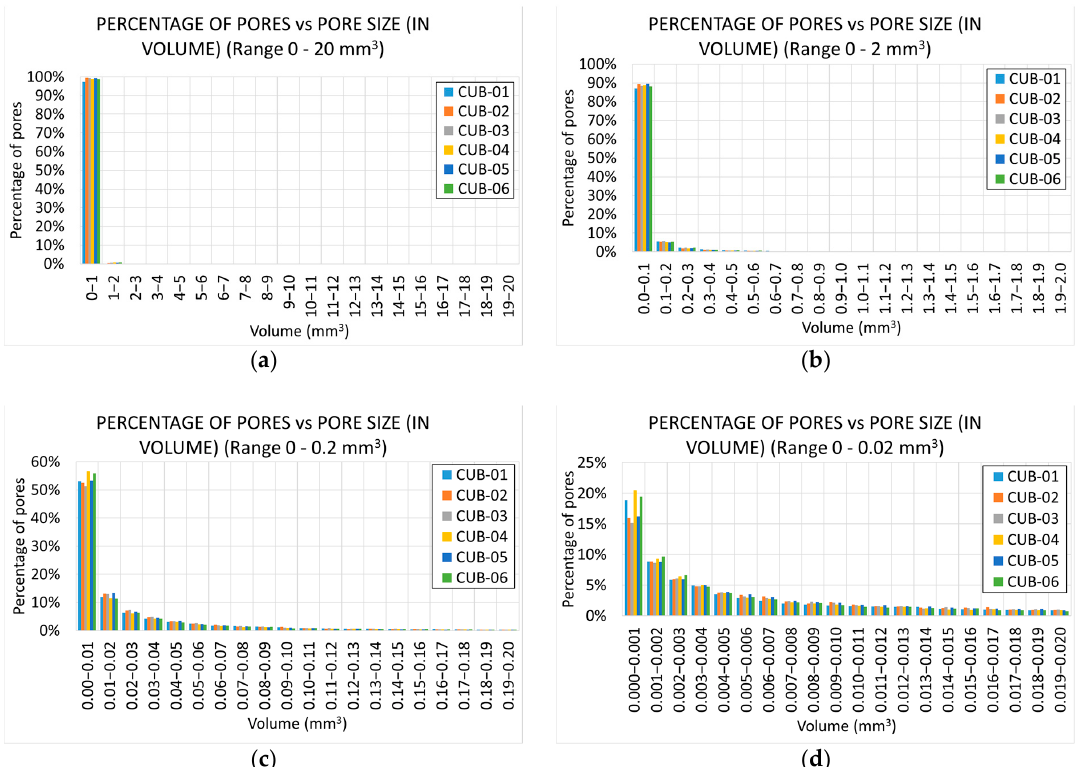
Figure 19. Histograms of pore distribution (in volume) for different ranges, from the largest to the smallest ( a – d ).